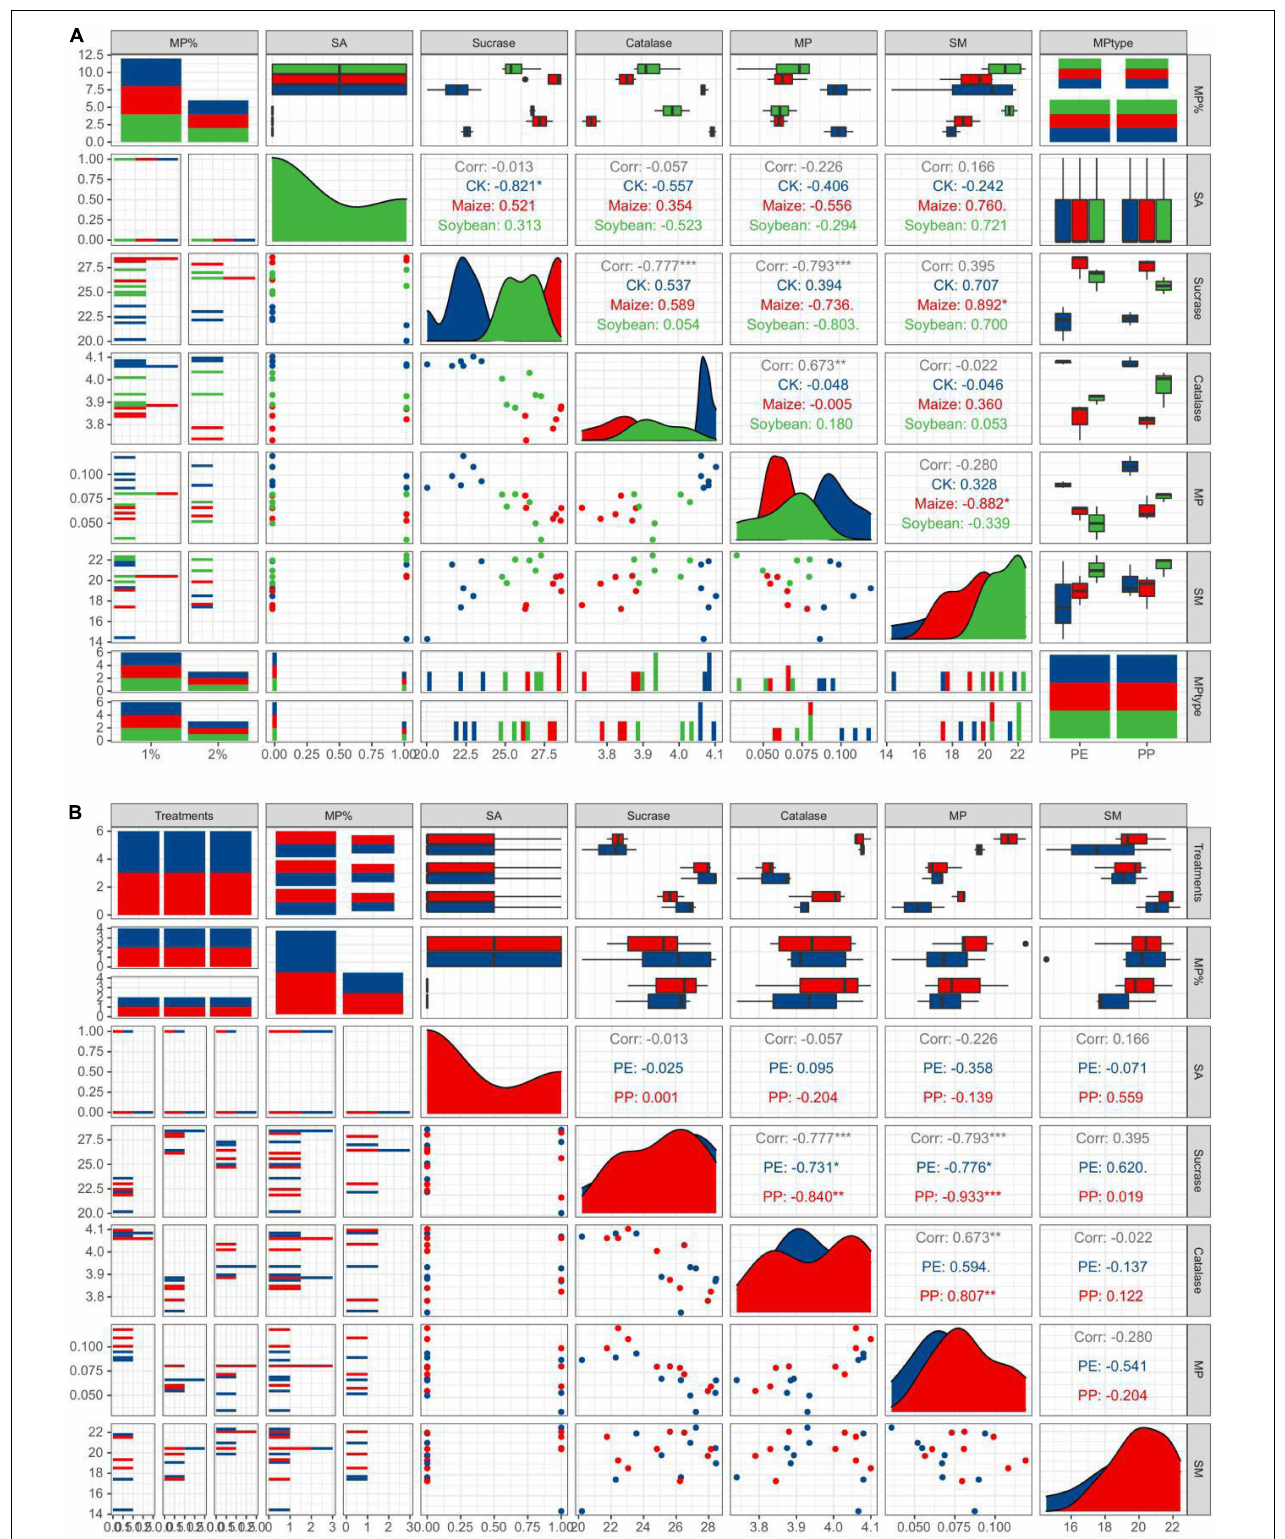
FIGURE 7 | Easy pairs with different crop treatments and different MP types. (A) A correlation analysis between indicators in different crop treatments. (B) A correlation analysis between indicators under different MP types. MP% is the original MP addition. MP is MP mass after crop growth.